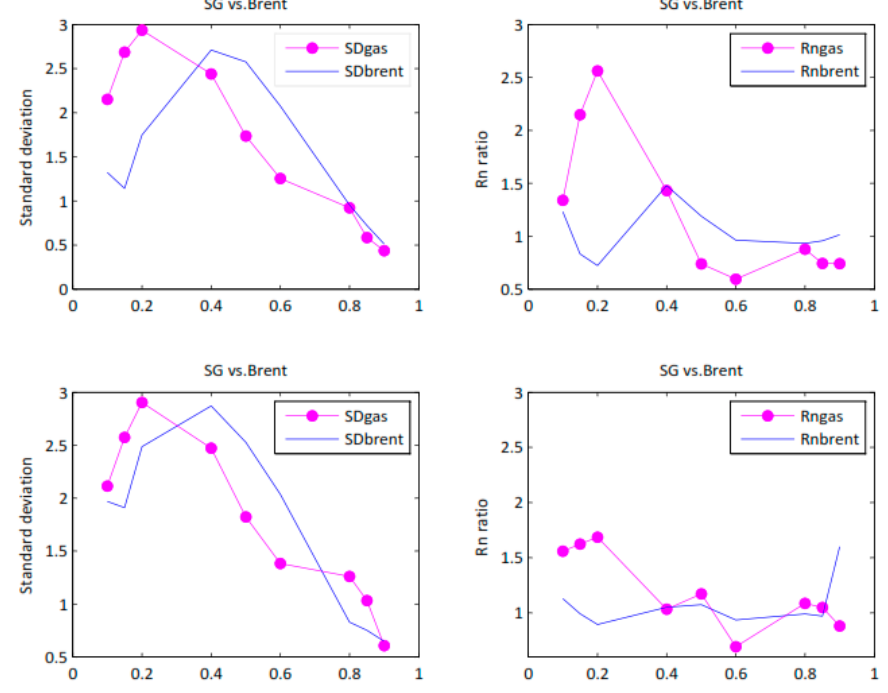
Figure 2. The scope of Rn ratio over 2002–2013 ( top ) and 2002–2016 ( below ).